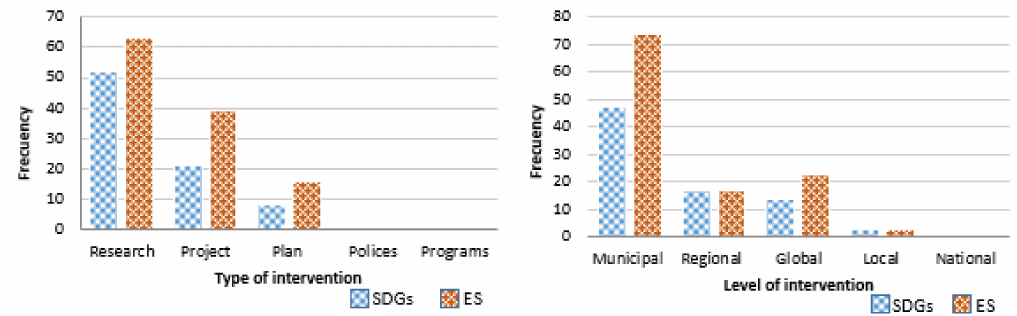
Figure 5. Frequency of ES and SDG and the different types and levels of